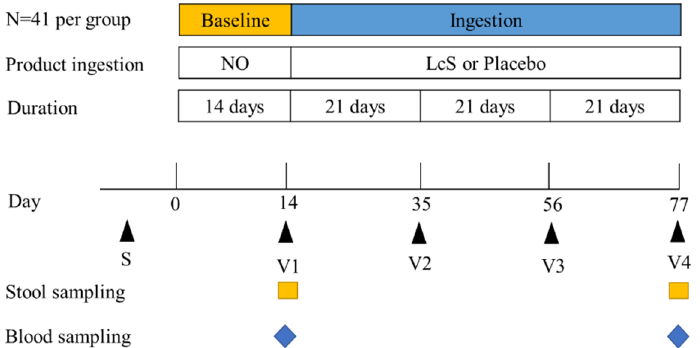
Figure 1. Study design. LcS: the fermented dairy beverage contained Lacticaseibacillus paracasei YIT 9029, V1–V4: visit 1–visit 4. 9029, V1–V4: visit 1–visit